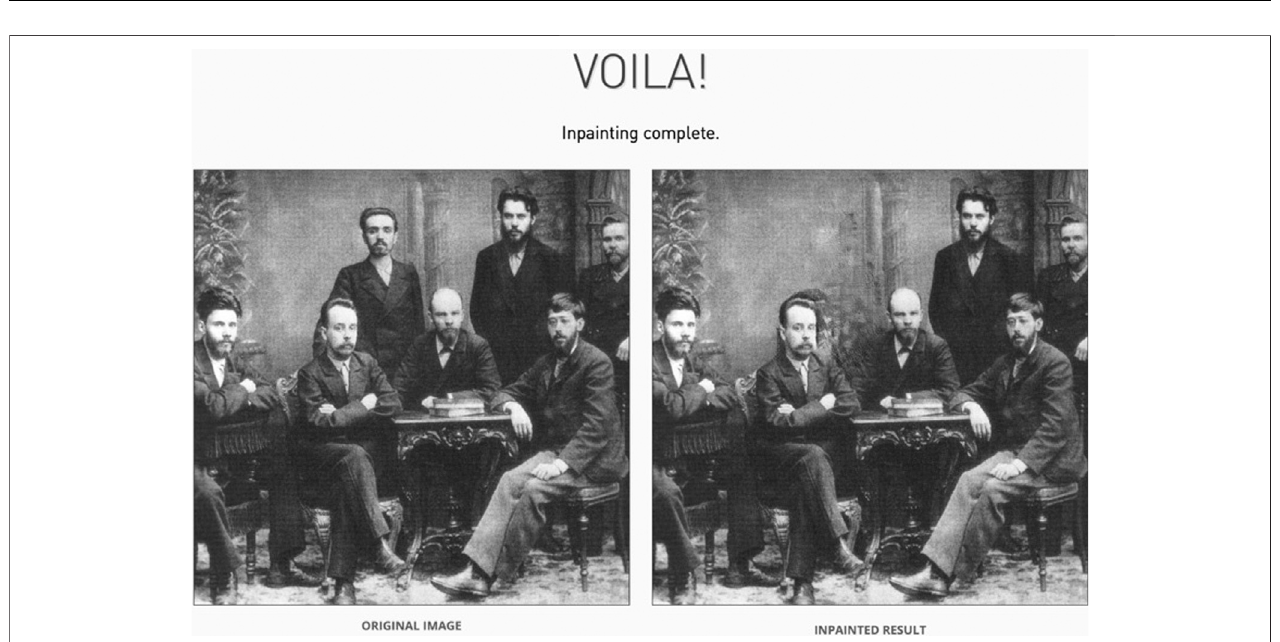
FIGURE 3 | Output image of NVIDIA Image Inpainting. The result shows some signs of manipulation. Source: Wikipedia. Created by the authors using NVIDIA Inpainting (NVIDIA, 2020). Image from Wikipedia (Wikipedia, 2020).